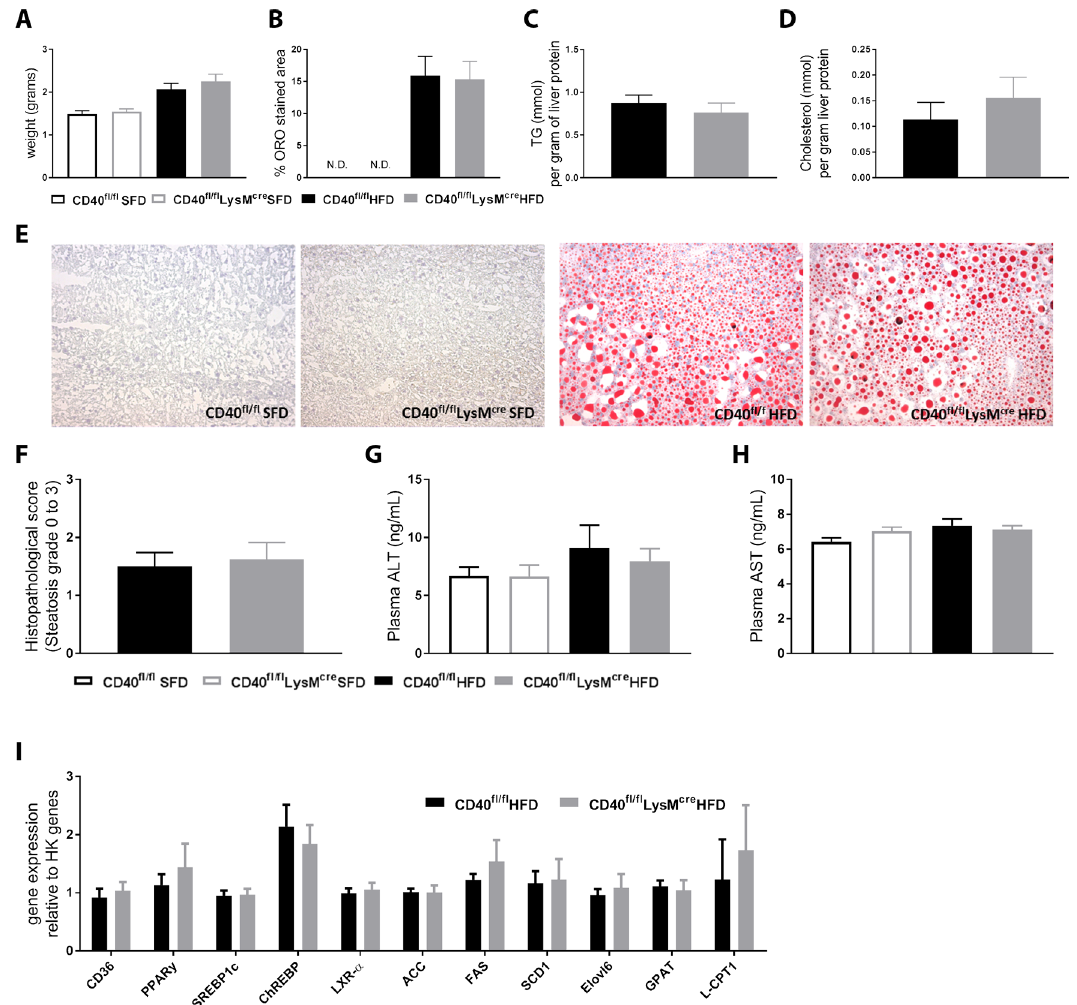
Fig 5. Lipid accumulation was not affected by deficiency of macrophage CD40. (A) Liver weight (n = 16 for HFD and n = 7 for SFD) (B) Quantification of oil-red-o stained area in the liver (n = 16 for HFD and n = 7 for SFD). (C) Liver TG levels (n = 6-9/group). (D) Liver total cholesterol levels (n = 6-9/group). (E) Representative pictures of ORO staining of the livers. (F) Histopathological score of liver steatosis (n = 16/group). (G) . Plasma ALT levels (n = 7-9/group). (H) . Plasma AST levels (n = 7-9/group). (I) mRNA expression of liver lipid metabolism genes (n = 7-10/group). Data is presented as mean ± SEM. N.D. means ‘not detectable’.